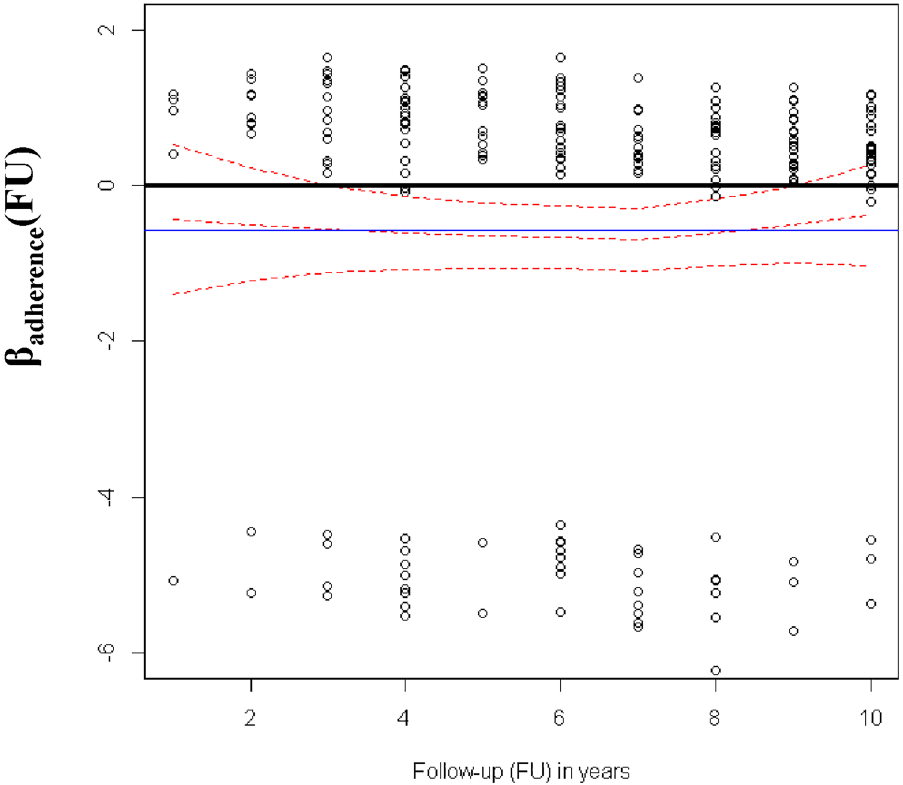
Figure 2. Plot of the time-dependent effect of “adherence” with 95% confidence intervals: in blue, log-hazard ratio coefficient, β adherence , estimated from the model with splines (model C.3) considering adherence as constant effect; in red, “time-varying” effect of “adherence” estimated through LOWESS regression of the scaled Schoenfeld residuals from model C.3 versus time (follow-up).